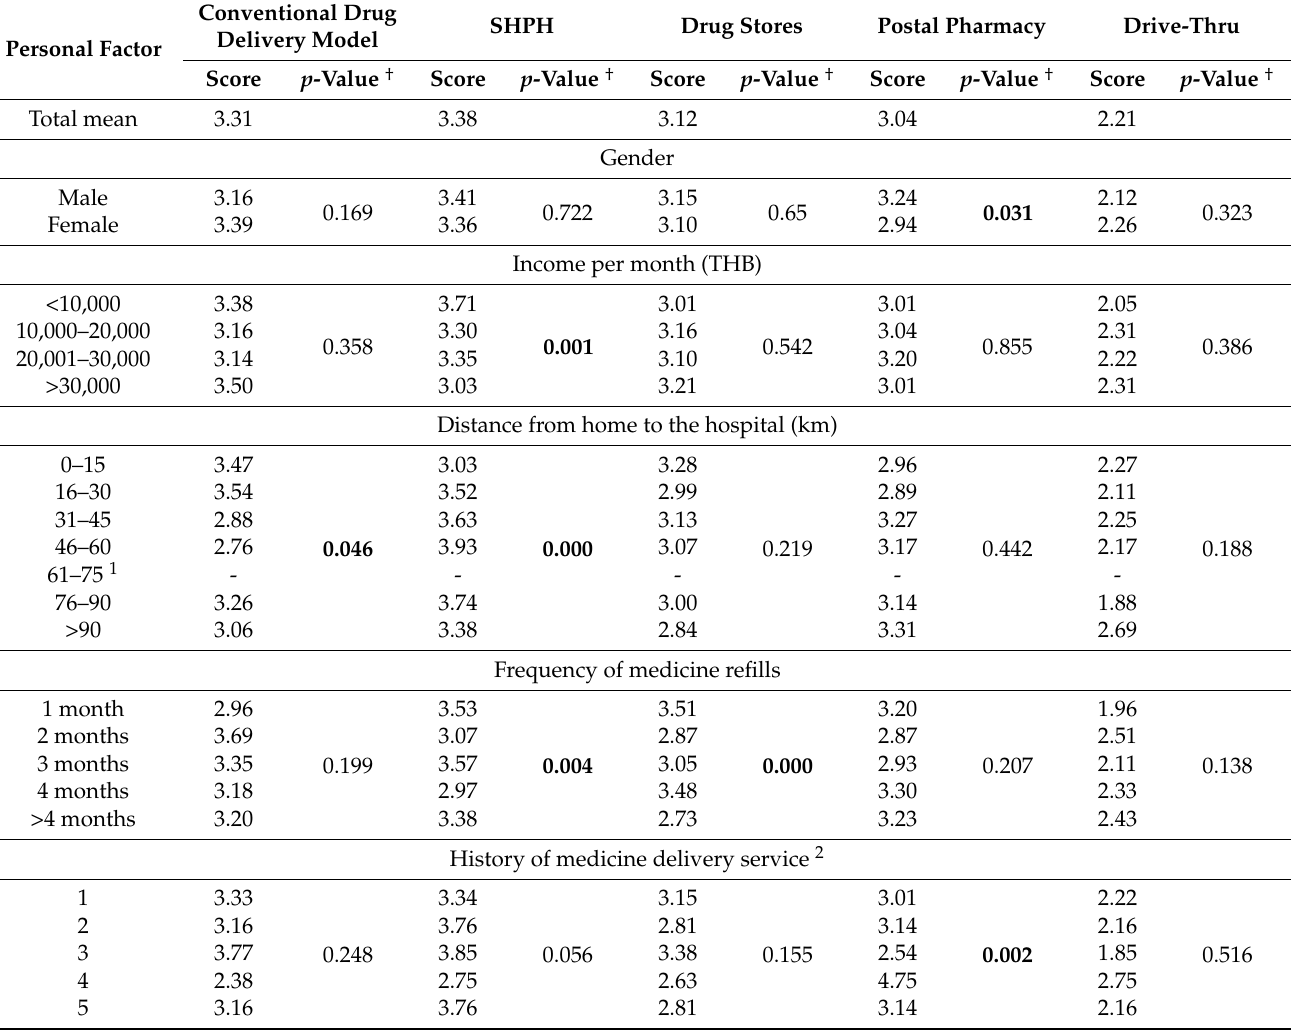
Table 2. The personal factors related to the desired medicine delivery methods of NCD patients ( n =